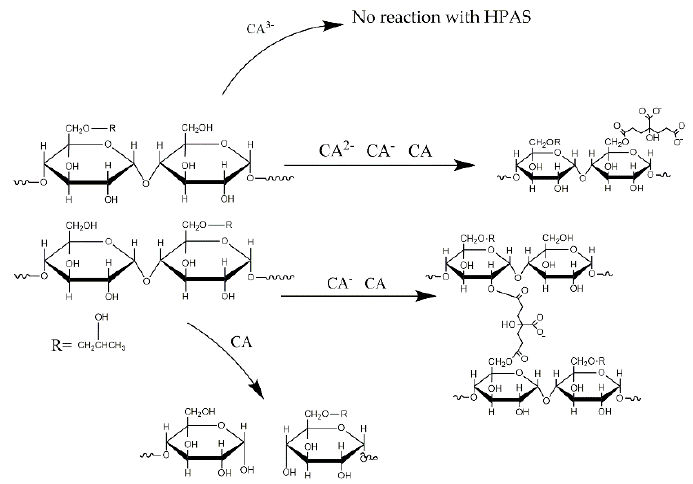
Figure 8. Reaction of citric acid and hydroxypropyl high amylomaize starch under various pH by melting extrusion.